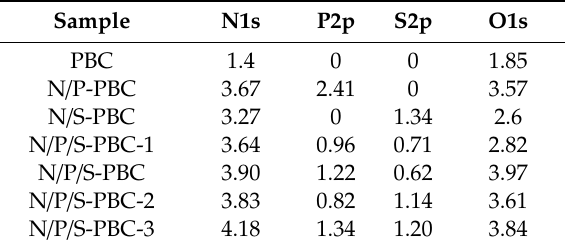
Table 3. The contents of nitrogen, phosphorous, sulfur and oxygen element (atom ratio, derived from XPS analysis) of different PBCs (the deviation of all test data is within 5%).